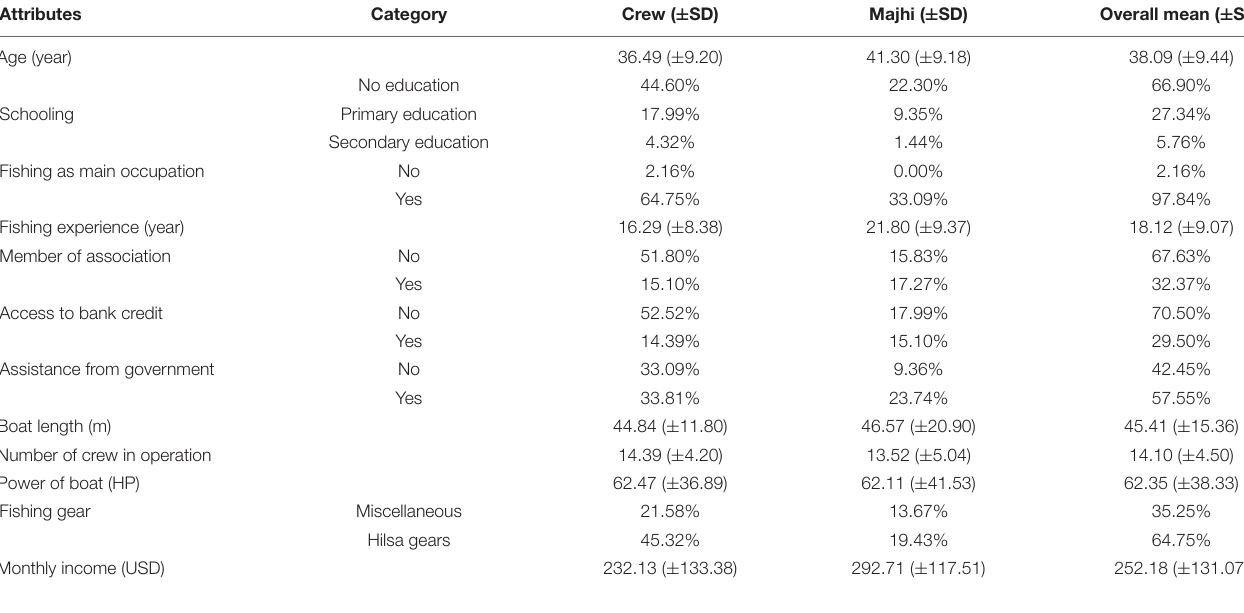
TABLE 2 | Socioeconomic profile of the respondents in the fishers’